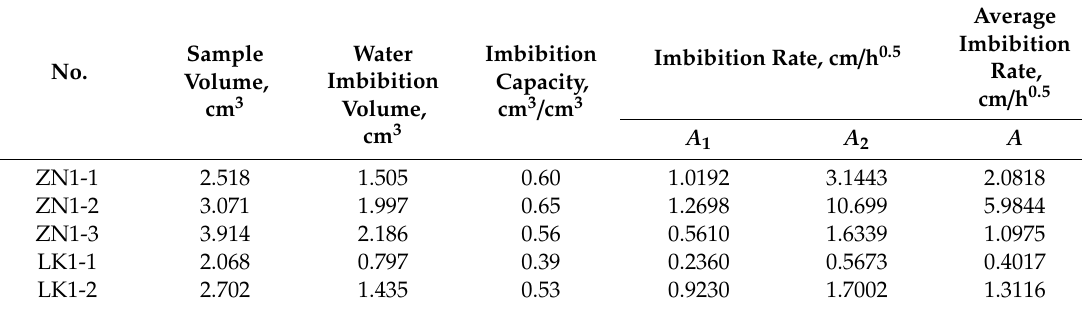
Table 5. Imbibition capacity and imbibition rate.